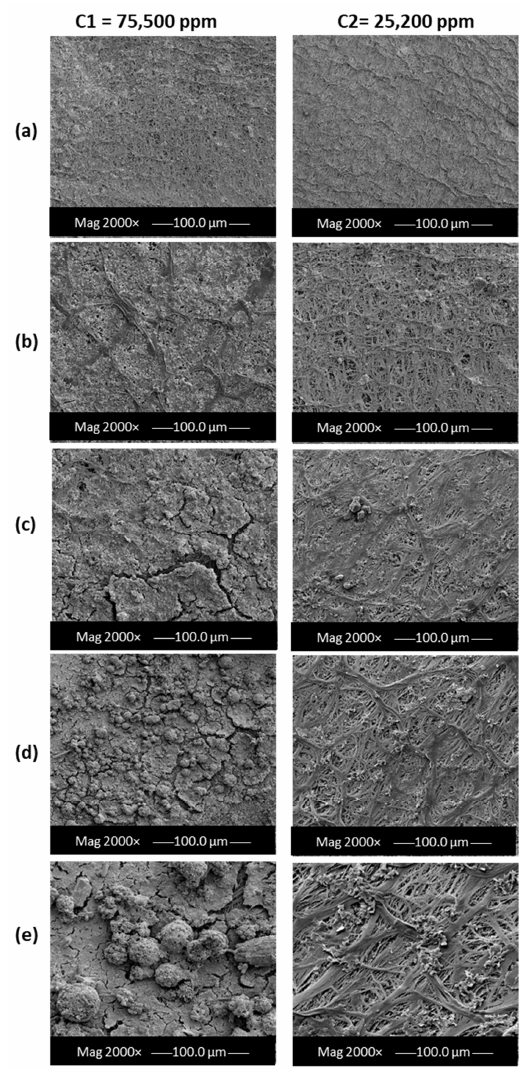
Figure 3. SEM images for PE membranes after ( a ) 20, ( b ) 40, ( c ) 60, ( d ) 80, and ( e ) 100 h of pilot-scale MD